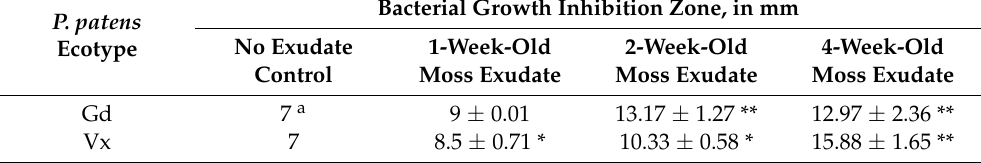
a Cellulose disk diameter is 7 mm (no antibacterial activity). *—statistical significance p ≤ 0.05; **—statistical significance p ≤